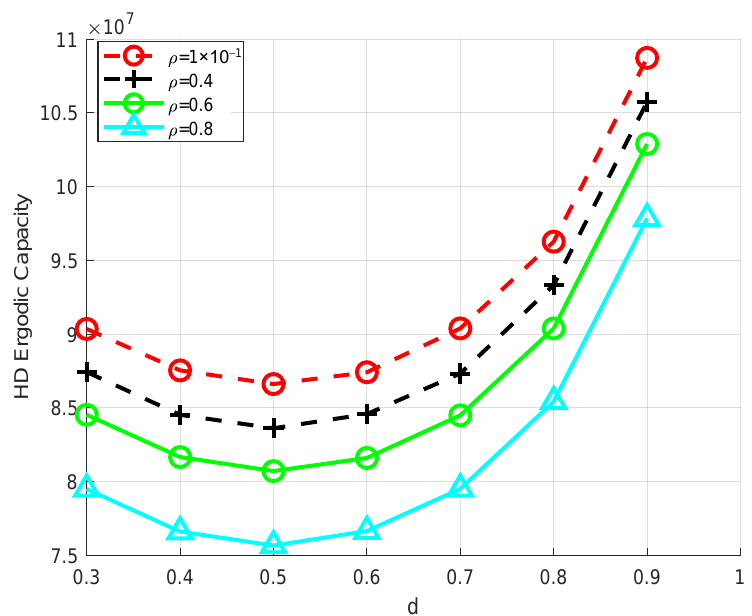
Figure 8. Capacity comparison of half-duplex with different distances.